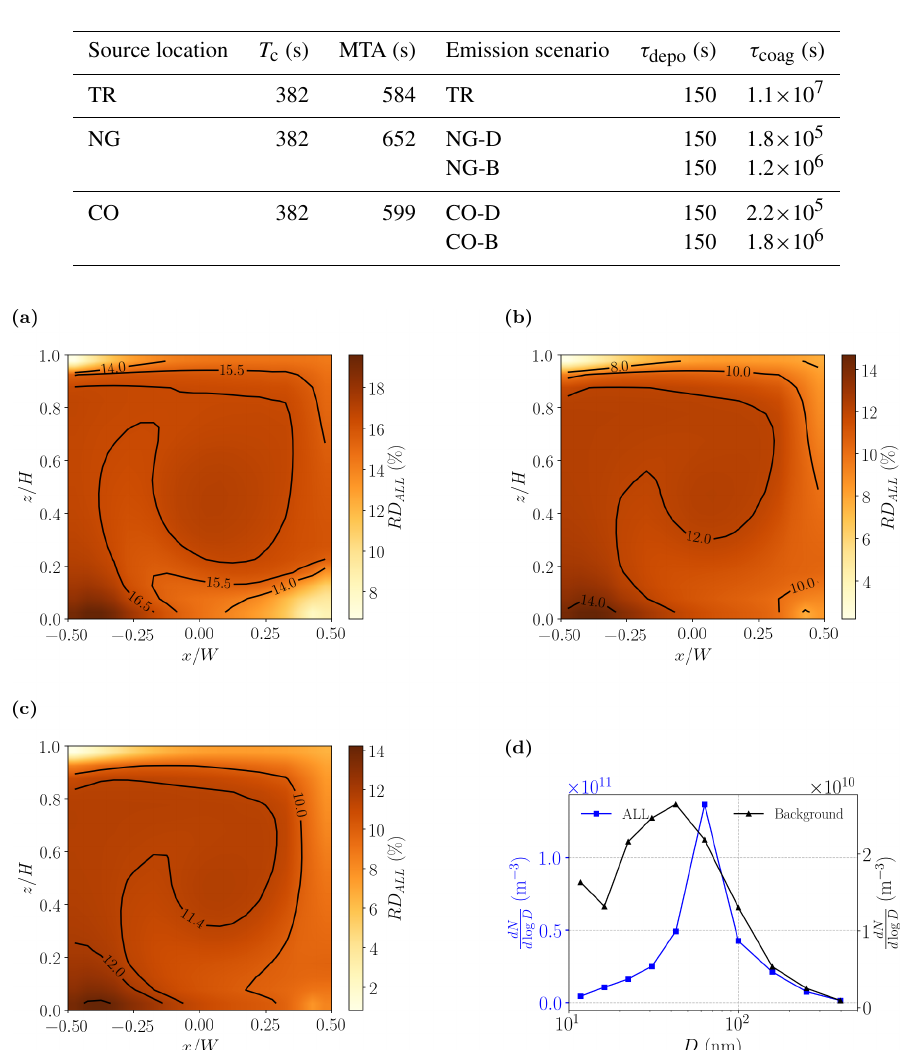
Table 5. Dynamical and aerosol timescales for different emission scenarios.